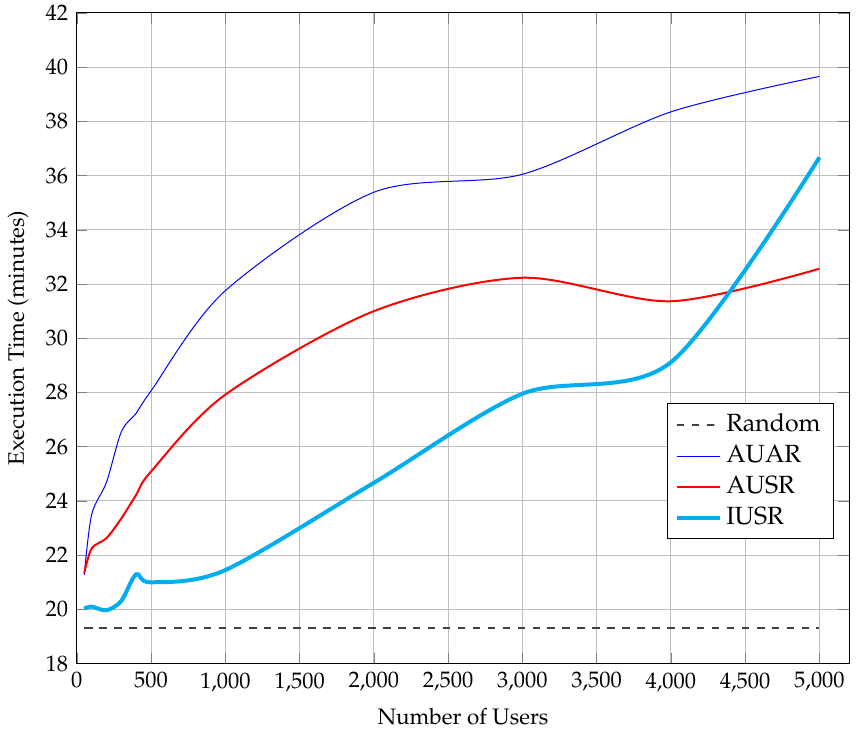
Figure 4. Execution time for different numbers of user replications for the three